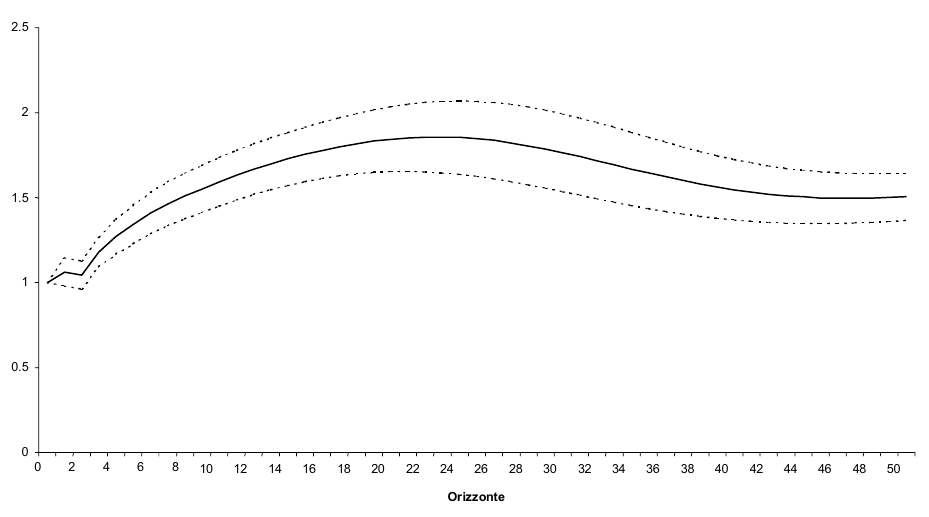
Figura 2 – Profilo di persistenza dell’output aggregato (modello M3